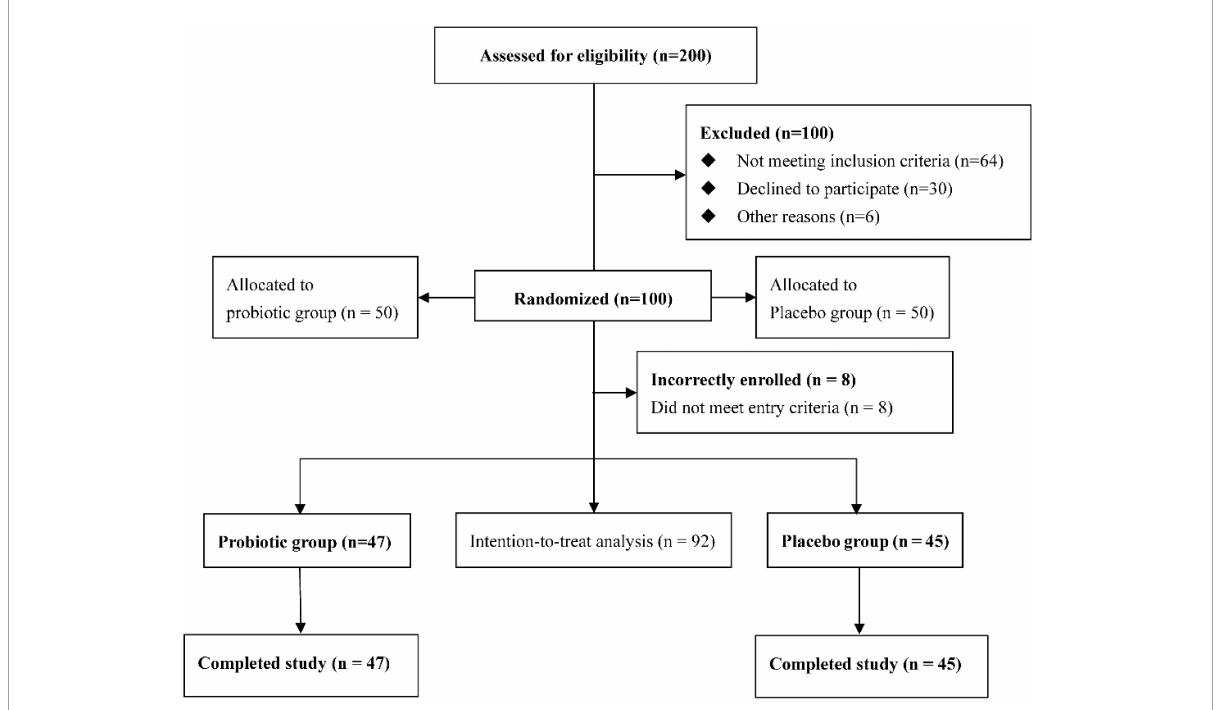
FIGURE1 Participants’